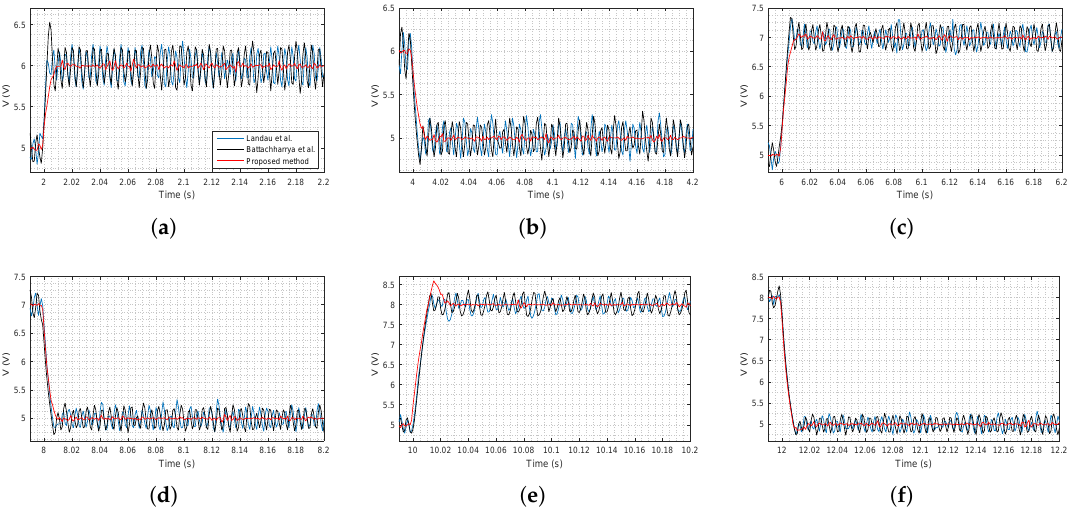
Figure 12. Experimental results of the positive voltage setpoint variation. ( a ) V ref = 6.0 V; ( b ) V ref = 5.0 V; ( c ) V ref = 7.0 V; ( d ) V ref = 5.0 V; ( e ) V ref = 8.0 V; ( f ) V ref = 5.0